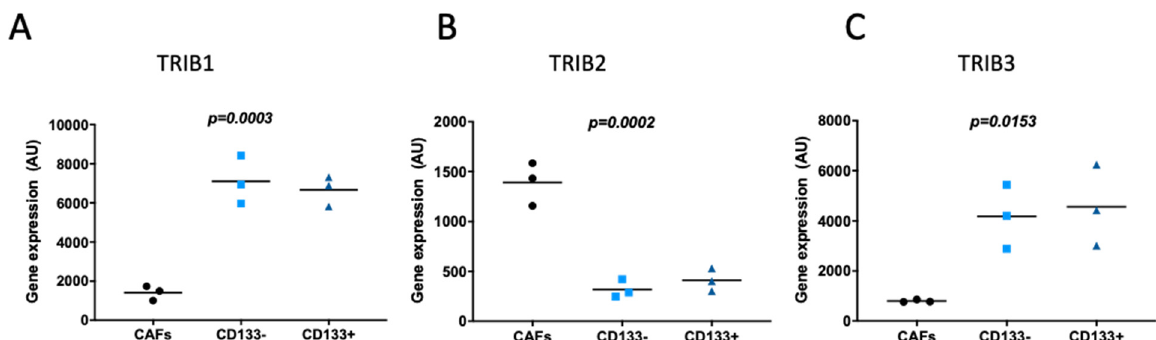
Figure 4. TRIB1 , TRIB2 , and TRIB3 gene expression in colorectal cancer (CRC) cells compared to carcinoma associated fibroblasts. ( A – C ): Carcinoma associated fibroblasts (CAFs), CD133-negative, and CD133-positive CRC cells isolated from stage II patient samples (GDS4385). Samples are plotted individually ( n = 3). TRIB1 (( A )—202241_at), TRIB2 (( B )— 202478_at), and TRIB3 (( C )—218145_at) gene expression is represented as arbitrary units (AU). Ordinary one-way ANOVA was performed, and the p value is represented for each graph. The horizontal bars represent the mean of the values in each group.